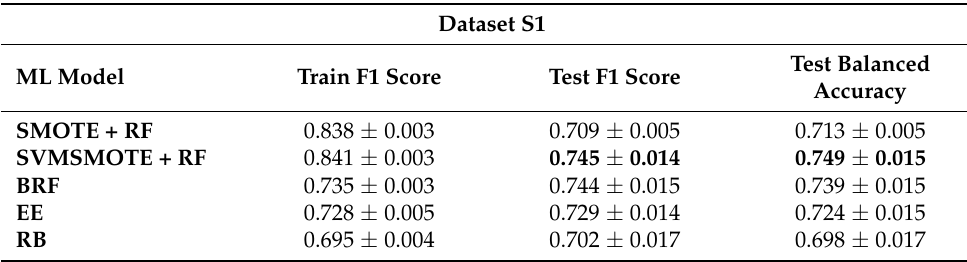
Table 4. Global evaluation metrics for each learning model built with the information at the end of first semester (dataset S1). Values represent mean and standard deviation.